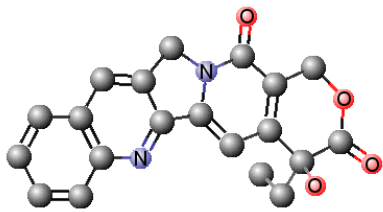
Figure 1. 3D chemical structure of CPT generated with ‘Chemicalize’ tool from Chemaxon ® software. Table 1. In silico prediction of several physicochemical descriptors using the CPT chemical structure on Chemaxon ® software.